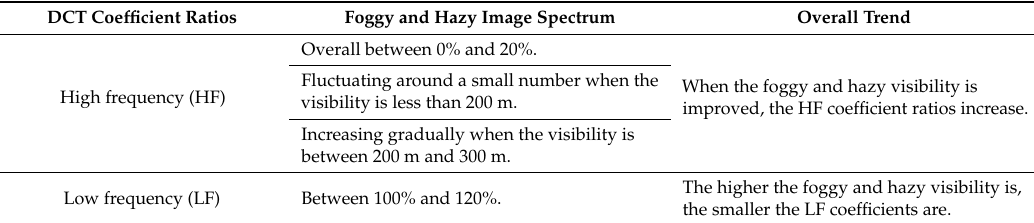
Table 4. Spectral features of foggy and hazy